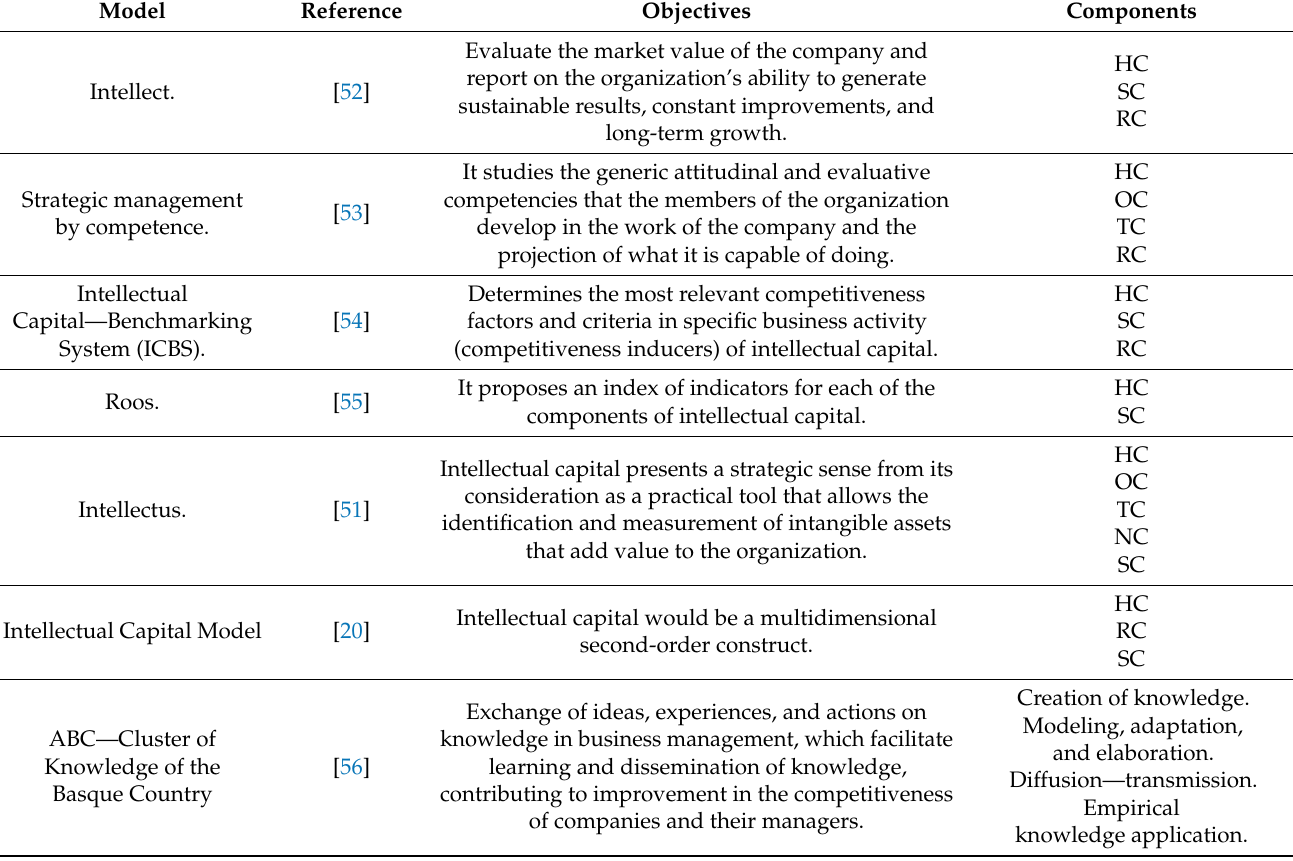
Table 1. Intellectual capital models of the strategic–corporate